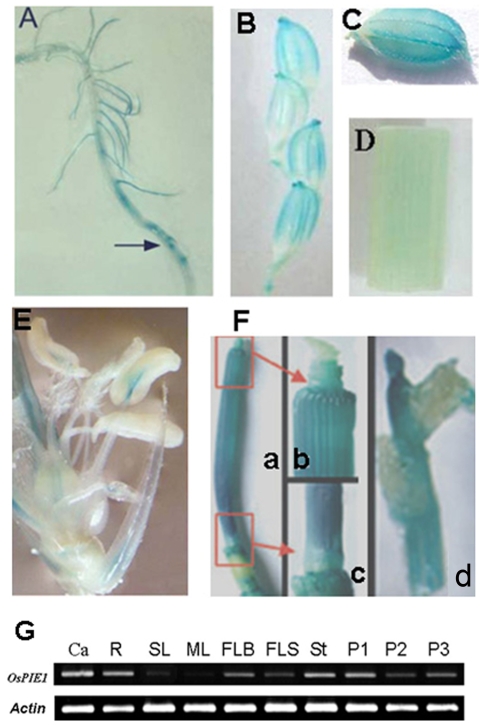
Expression patterns of OsPIE1 in rice.(A) to (F) Histochemical GUS assays in the OsPIE1 promoter:GUS transgenic lines. (A) GUS staining in the primary root with lateral roots. Arrow indicates the lateral root initiation site. (B) to (E) GUS staining in young spikelets (B), the mature spikelet (C), the young leaf (D) and the flower (E). (F) GUS activity in the young shoot (a), including the rapid elongation zones of culm internodes before panicle development (see the enlarged images, b and c), and the elongation zone of peduncle (d). (G) RT-PCR analysis of OsPIE1 mRNA expression in different tissues or organs. Tissues or organs used were: Ca, callus; R,7-day-old roots; SL,7-day-old leaves; ML, mature leaves; FLB, flag leaf blade; FLS, flag leaf sheath; St, stem; P1,1 to 2-cm-long panicles; P2, 3 to 5-cm-long panicles; and P3, 5 to 8-cm-long panicles. The rice Actin gene was used as an internal control.